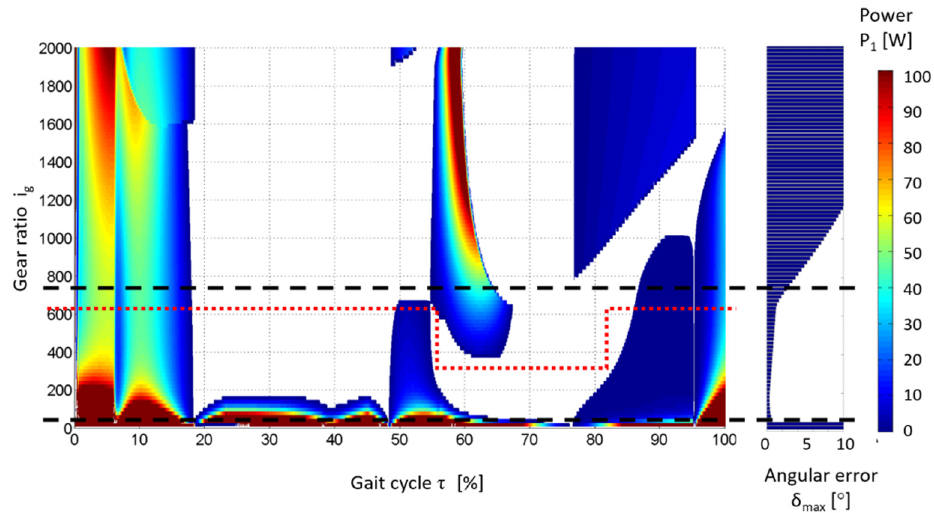
Figure 16. Graph of the instantaneous energy demand at the hip joint and the maximum profile error for the tested gear ratios while performing steps of 0.4 m.